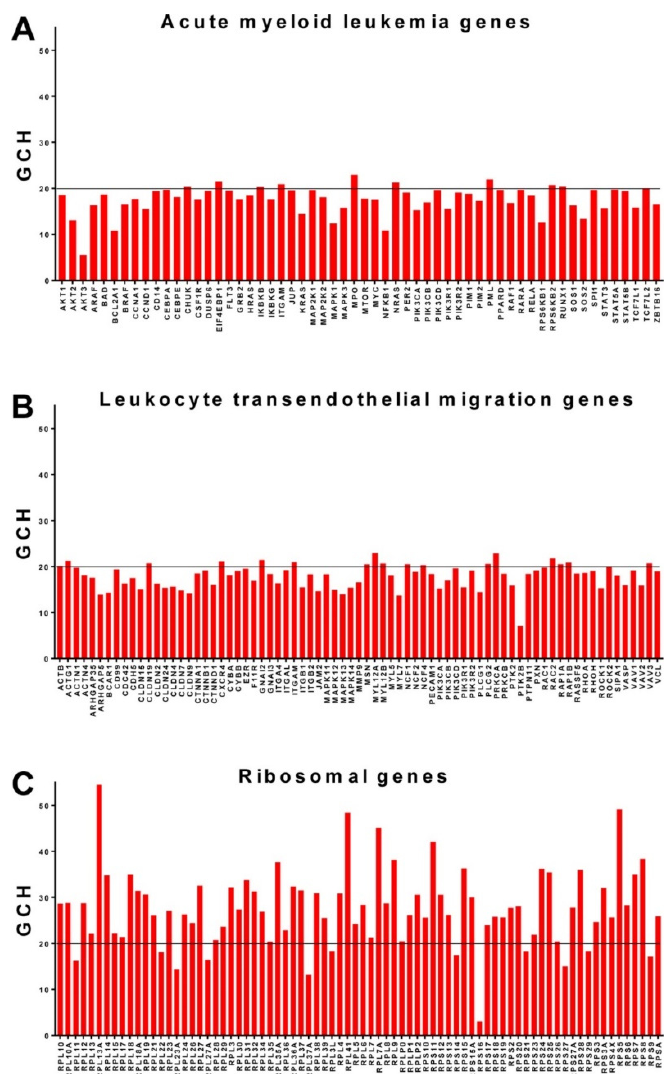
Figure 5. Data from GSE72415: Gene Commanding Height (GCH) scores in the acute promyelocytic leukemia cell line HL-60. ( A ). GCH scores of genes associated with acute myeloid leukemia. ( B ). GHC scores of genes associated with KEGG pathway of leukocyte transendothelial migration. ( C ). GCH scores of the ribosomal